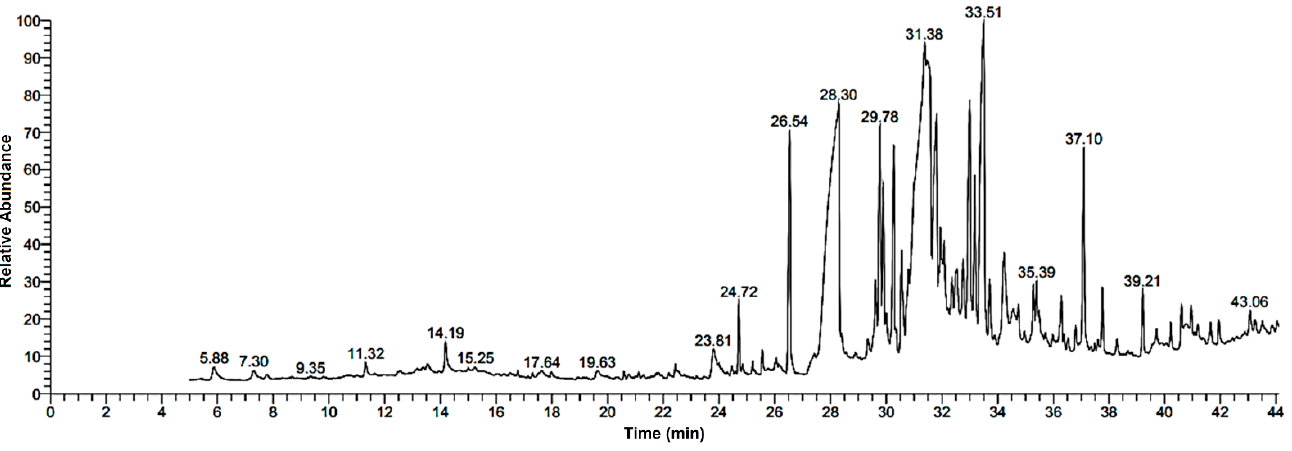
Figure 3. HPLC chromatogram of phenolic acids of M. pulegium extract. Figure 4. HPLC chromatogram of flavonoids of M. pulegium extract.